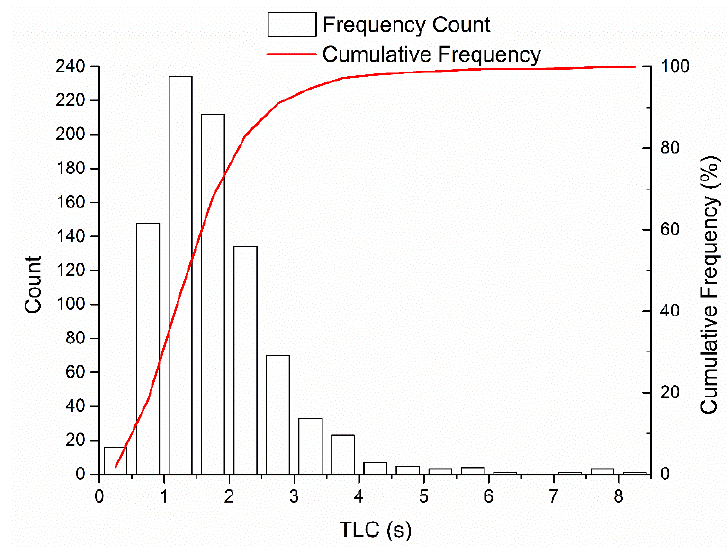
Figure 8. Time to Line Crossing (TLC) distribution.